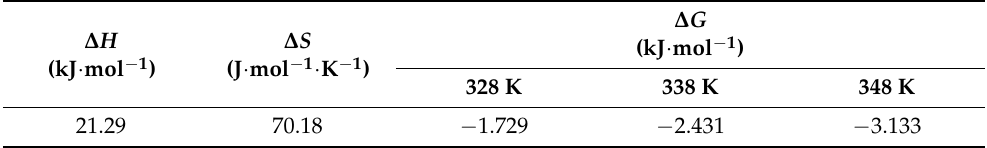
Table 2. Thermodynamic parameters of the calcium ions adsorption onto